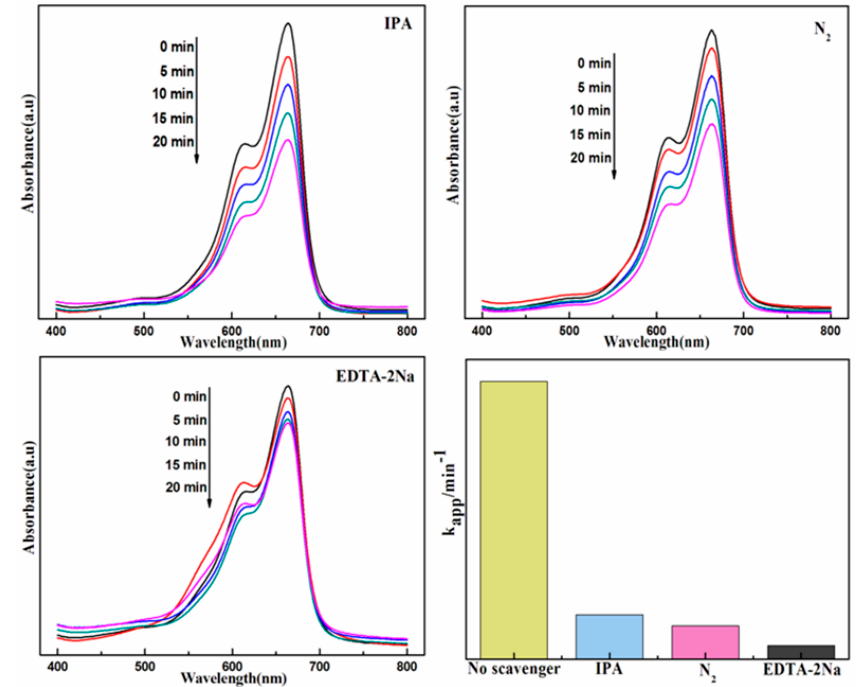
Figure 9. Effects of different scavengers on degradation of MB in the presence of Ag@AgBr(7 wt %)/Bi 2 O 2 CO 3 photocatalyst under visible-light irradiation. Bi 2 O 2 CO 3 photocatalyst under visible-light